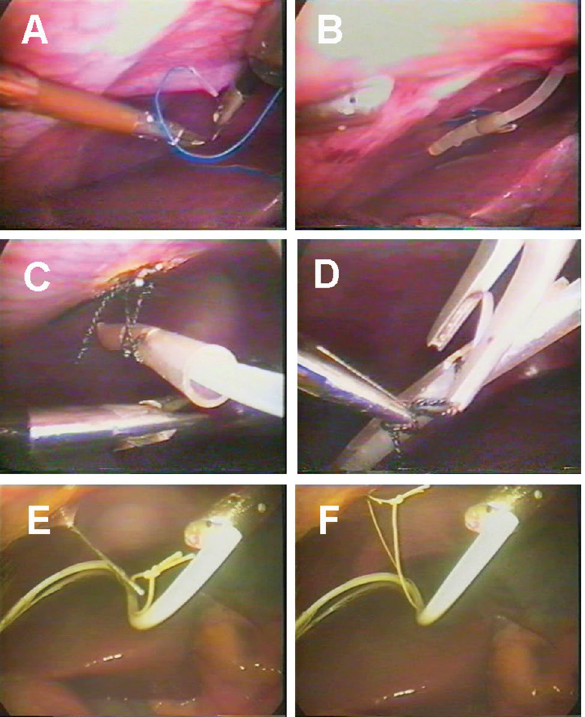
Figure 1. Endoscopic views showing the different fixation methods from within the peritoneal cavity. ( A ) and ( B ) Suture and ligature; ( C ) and ( D ) Titanium clip fixation; ( E ) and ( F ) Subcutaneous